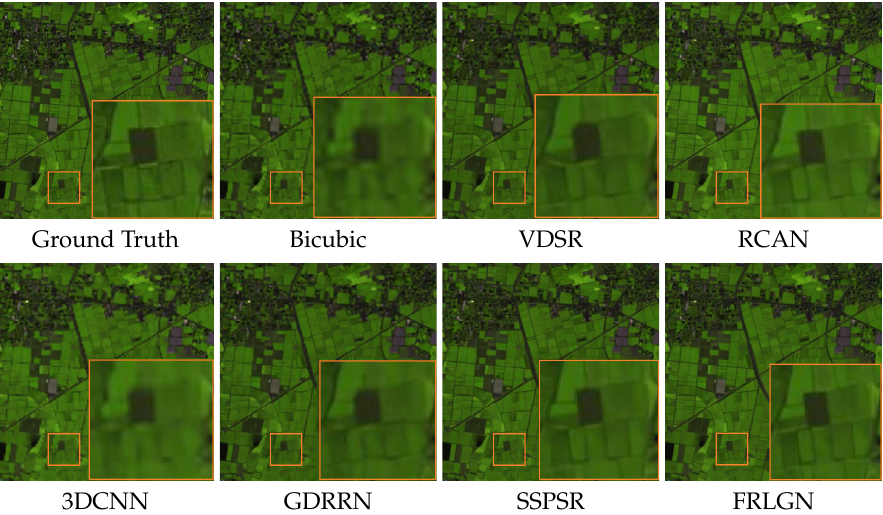
Figure 6. A reconstructed hyperspectral image from the Chikusei testing dataset with the scale factor Figure 6. The third reconstructed hyperspectral image from the Chikusei testing dataset with the 4, in which the bands 70-100-36 is treat as R-G-B. scale factor 4, in which the bands 70-100-36 are treated as